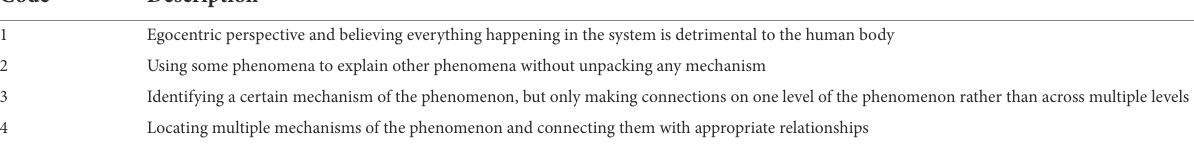
TABLE 3 Coding scheme for scoring student answers in systems thinking.